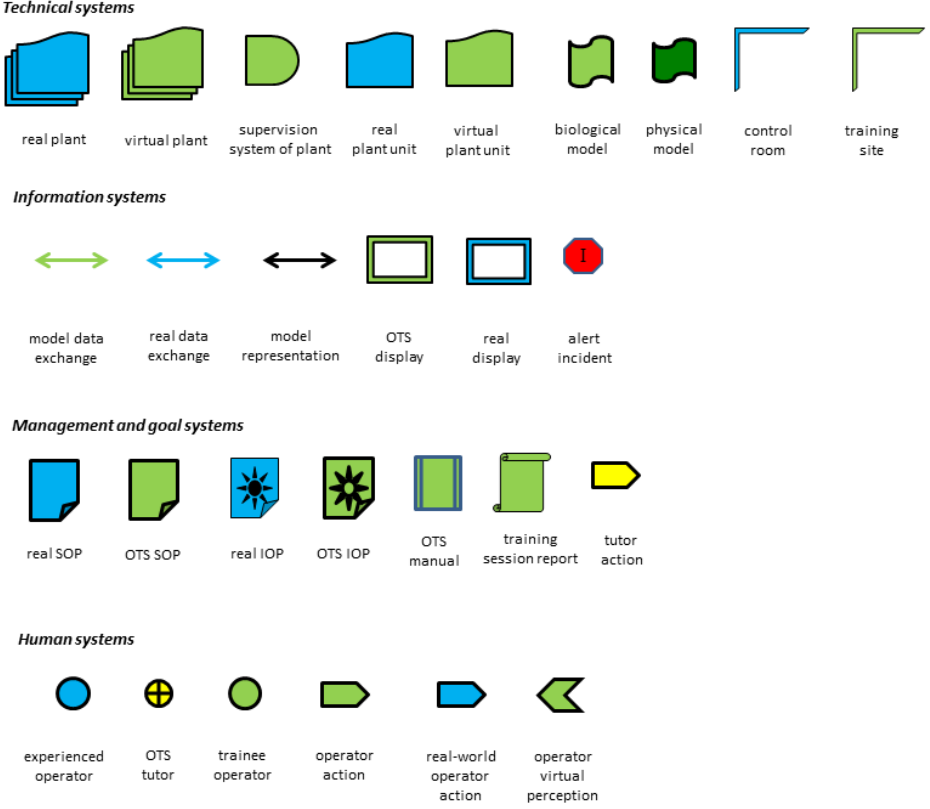
Figure 4. Functional elements of the training using the OTS of the bio-ethanol plant. These elements are to be used for considering diverse alternative configurations by permuting the elements. The elements are grouped according to the system they belong to in the Hubka-Eder